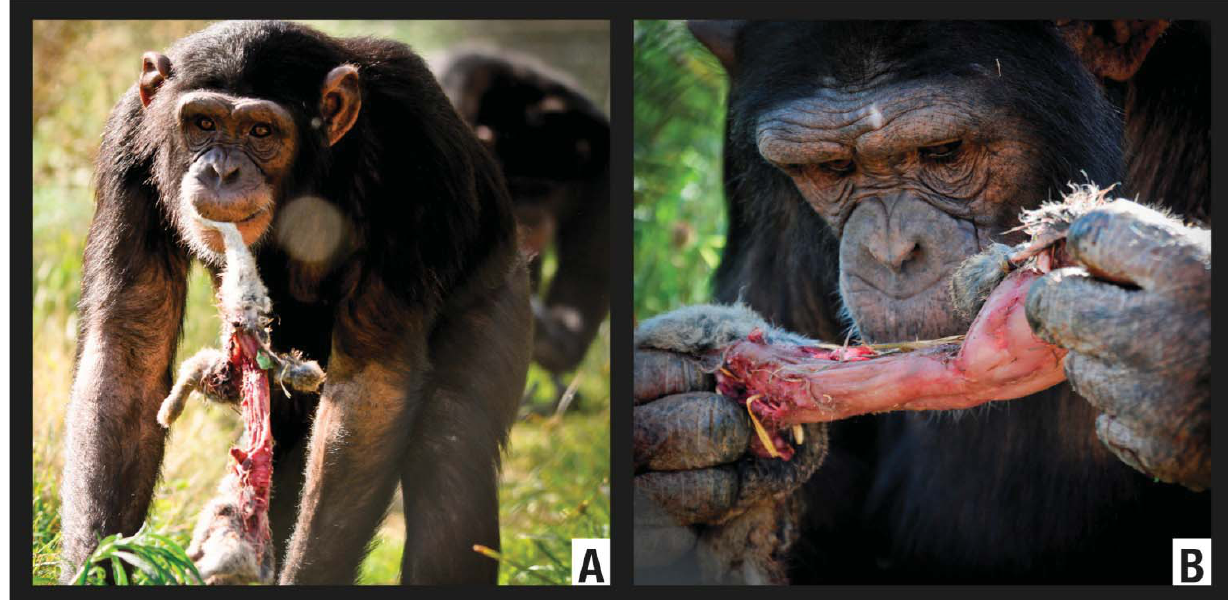
Figure 7. Predation of an Oryctolagus cuniculus (Episode H5) by Family Group. Transport and consumption of the